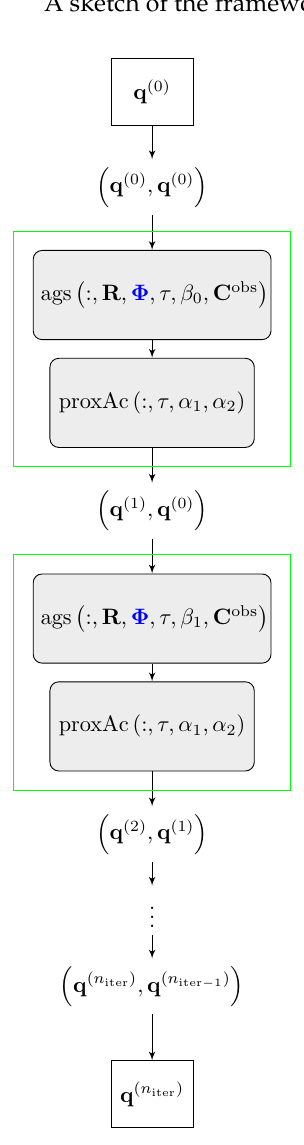
Figure 1. Sketch of the unrolled FISTA network . One forward pass through the network is F equivalent to the application of n iter FISTA iterations. Green bounding boxes indicate one iteration of the FISTA algorithm, trainable parameters are marked in